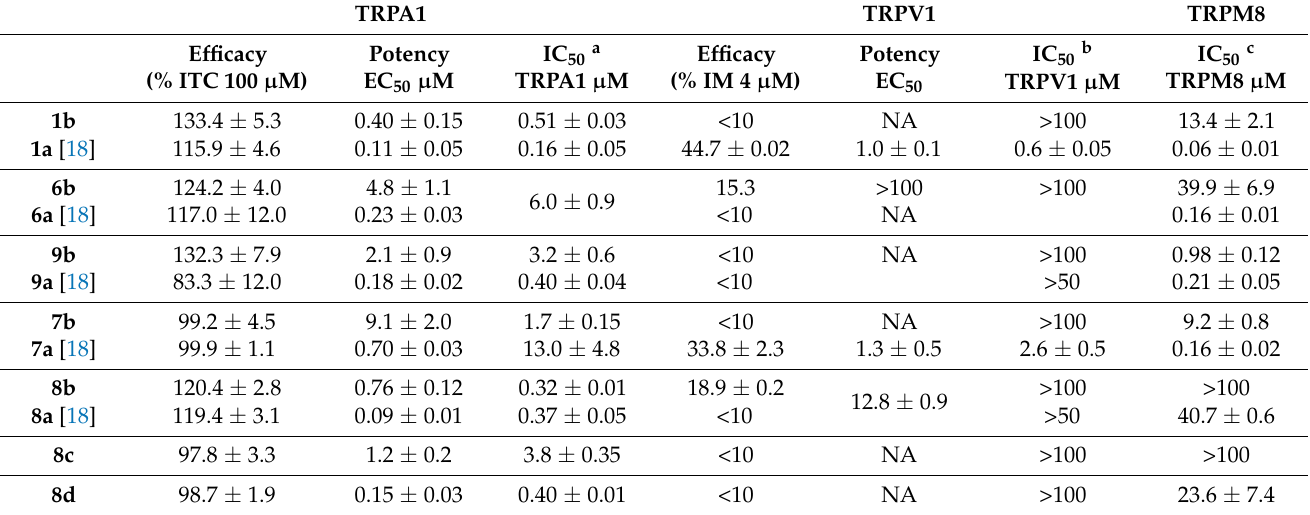
Table 1. Efficacy, potency, and inhibitory effect on TRPA1, TRPV1, and TRPM8 channels. TRPA1 TRPV1